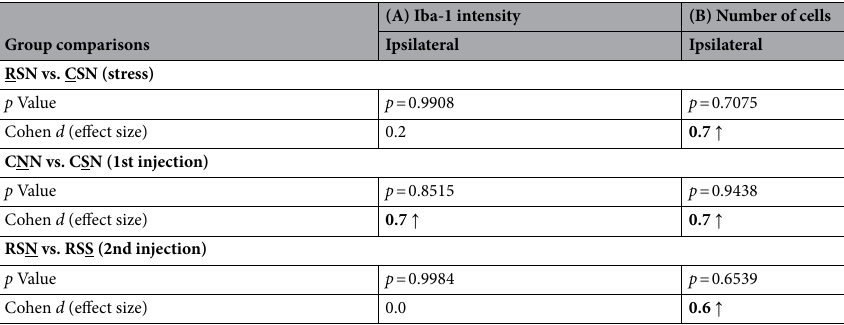
Table 2. Comparison of microglia staining intensity and cell numbers. The table shows the statistics for ( A ) Iba-1 staining intensity and ( B ) number of microglia cells, on the ipsilateral side of NGF/saline injections. The staining intensity and number of cells were analyzed for each ROI and averaged across the four ipsilateral ROIs within each animal. The statistics were performed using the mean ± SEM (n = 5 animals per group). P < 0.05 (two-way ANOVA followed by Tukey post hoc analysis) was considered significant and effect size was calculated using Cohen d . The group comparisons shown here are based on two factors: 1) repeated restraint stress (R) and control (C), 2) NGF (N) and saline (S) injections. Iba-1, ionized calcium binding adapter molecule 1; NGF, nerve growth factor. CSN: control + saline + NGF; RSS: repeated restraint stress + saline + saline; CNN: control + NGF + NGF; and RSN: repeated restraint stress + saline + NGF.